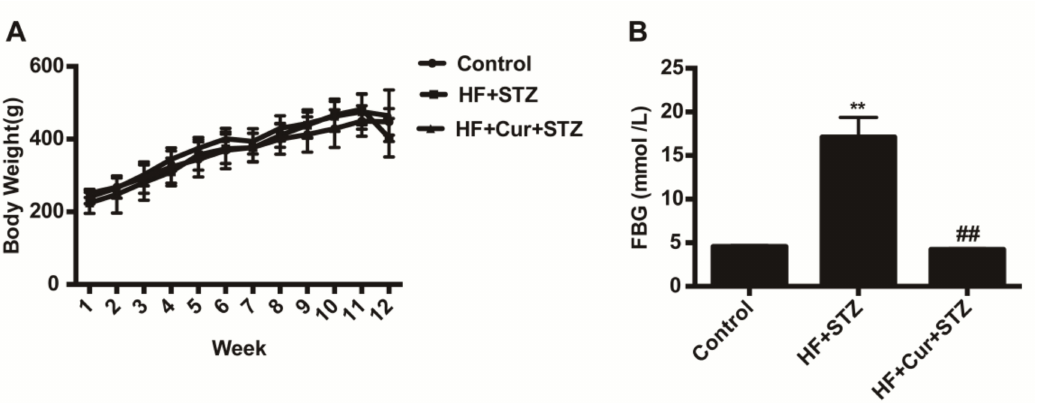
Figure 2. E ff ect of curcumin intervention on bodyweights and fasting blood glucose levels in rats fed a high-fat diet then treated with streptozotocin. ( A ) The e ff ect of curcumin intervention on body weight. ( B ) The e ff ect of curcumin intervention on fasting blood glucose. The data are expressed as the mean ± SEM. ** p < 0.01, compared with the control group; ## p < 0.01, compared with the HF + STZ group; Control ( n = 6), HF + STZ ( n = 10), and HF + Cur + STZ ( n =